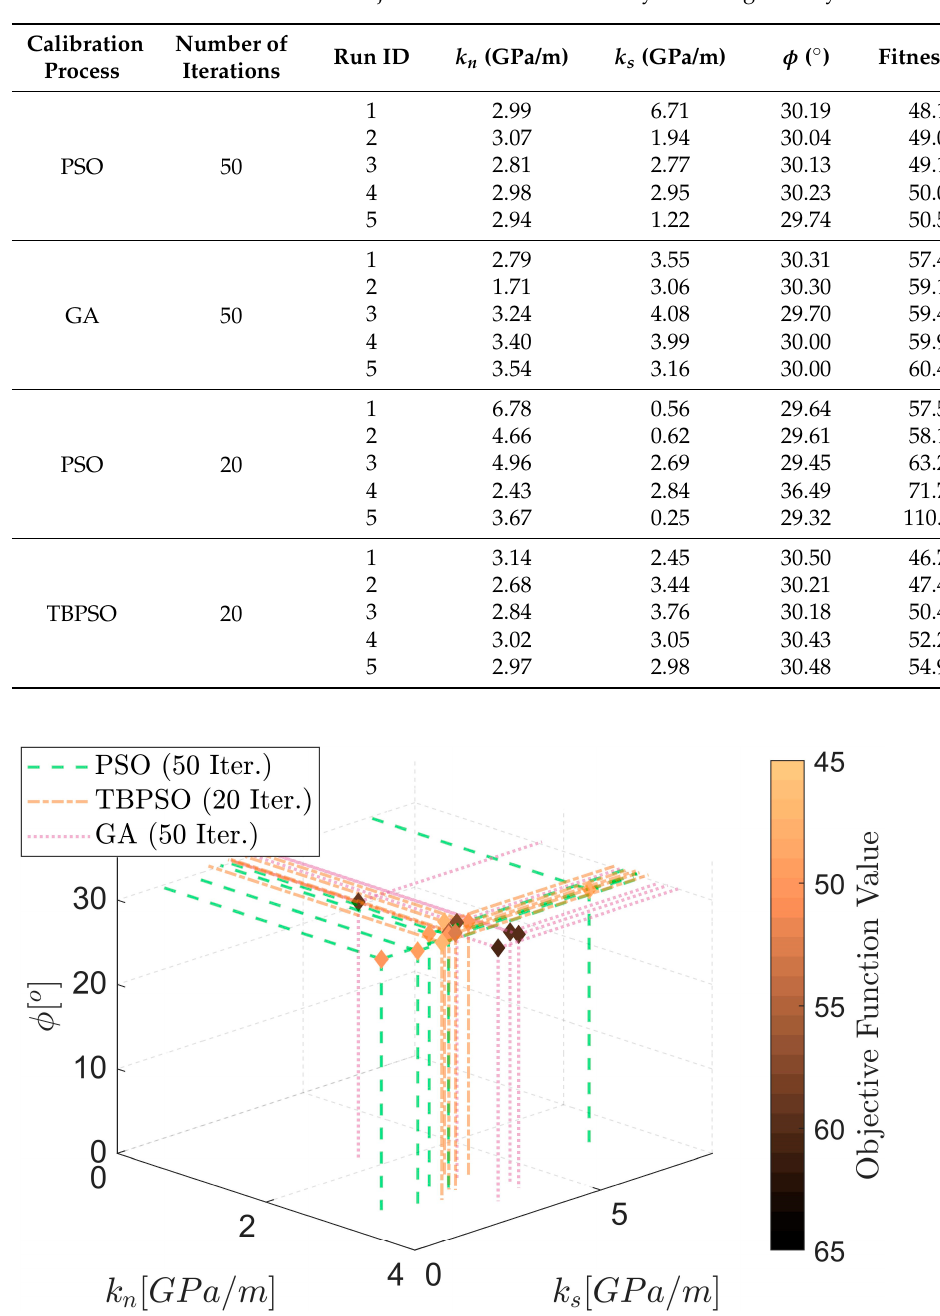
Figure 23. Position of calibrated material parameters of densely meshed geometry (objective function 2, PSO and GA: 50 iterations; TBPSO: 20 iterations). Table 4 . Five best solution sets for objective function 2 of densely meshed geometry.